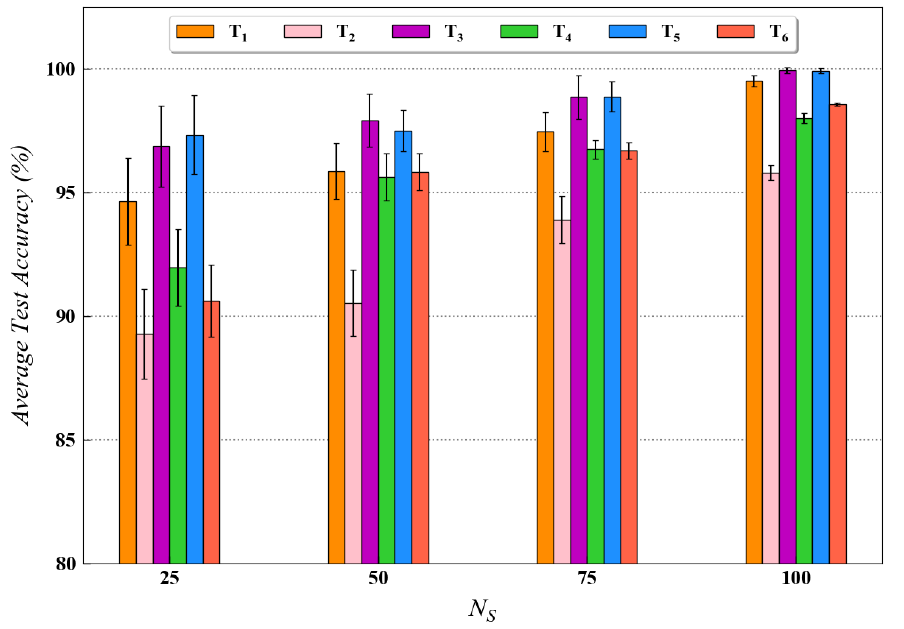
Figure 9. Performance analysis results for various transfer tasks of CWRU dataset with different training data size using the proposed method.